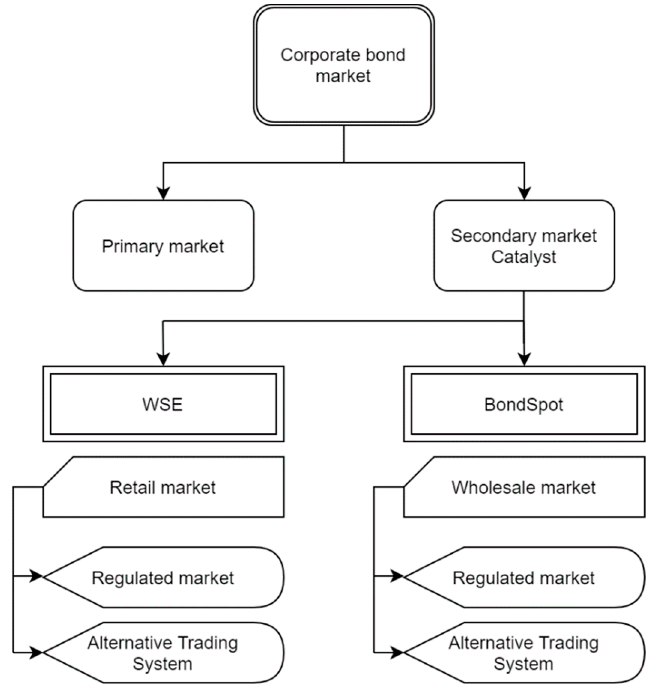
Figure 2. Structure of the corporate bond market. Source: (Bajak 2019, p. 94).